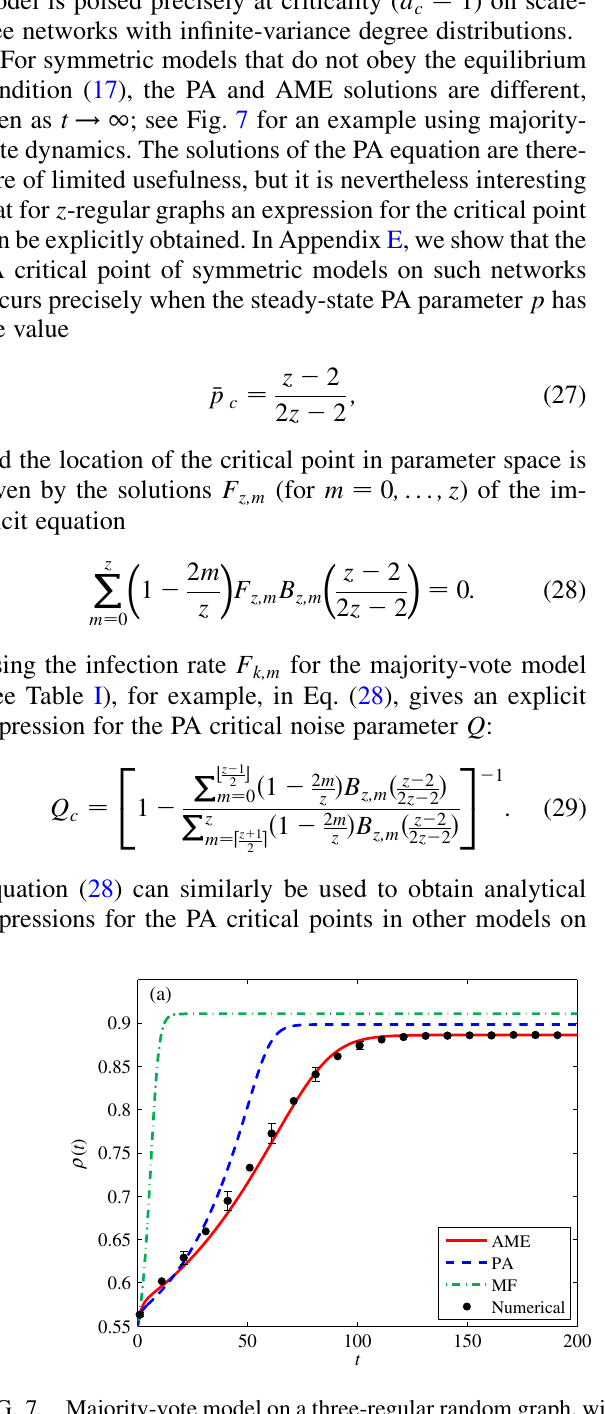
FIG. 7. Majority-vote model on a three-regular random graph, with (cid:5) ð 0 Þ ¼ 0 : 55 and noise parameter Q ¼ 0 : 07 . This nonequilibrium model does not obey condition (17), and the AME and PA solutions are not equal, even as t ! 1 , in contrast to Figs. 5 and